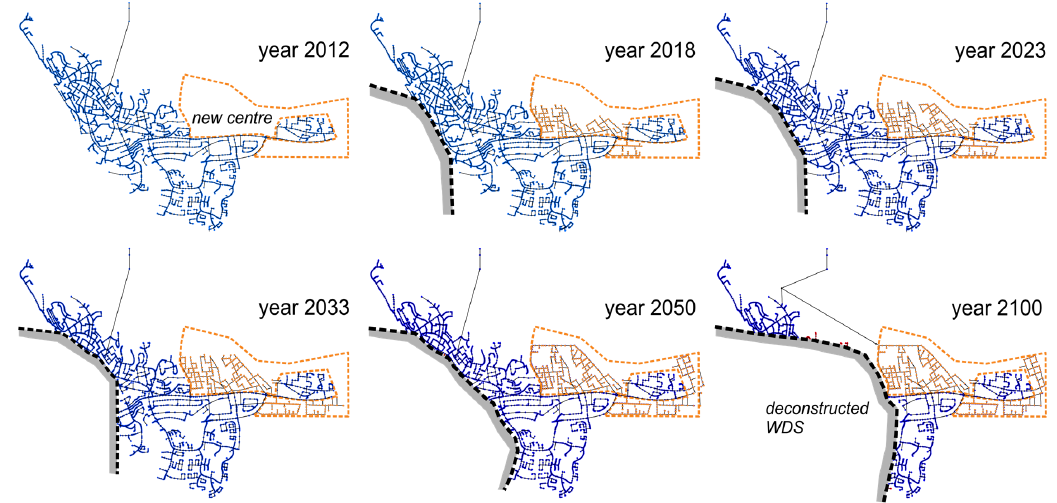
Figure 8. Transition stage models for Kiruna at six stages from year 2012 to year 2100.